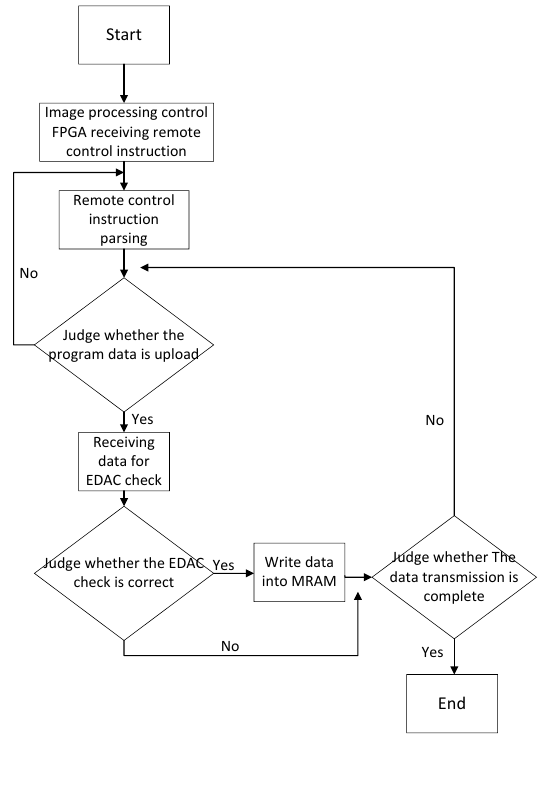
Figure 3. Program data update diagram of FPGA